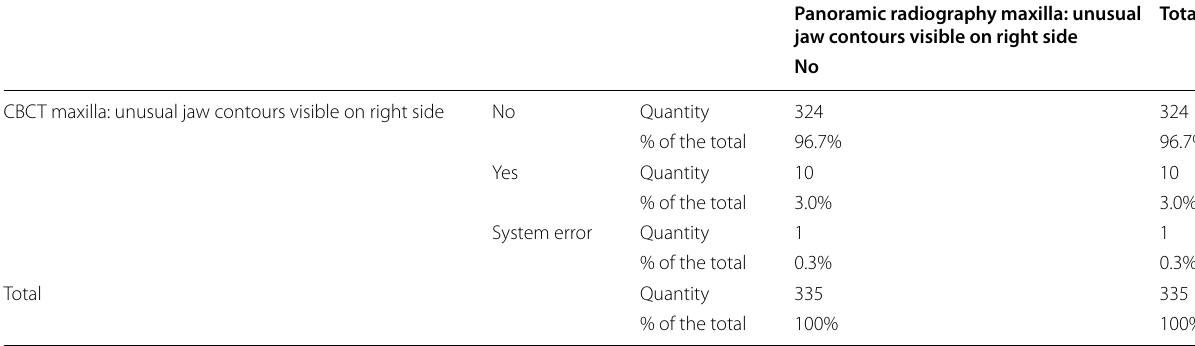
Table 2 Contingency table of the unusual jaw contour of the right maxilla in per cent